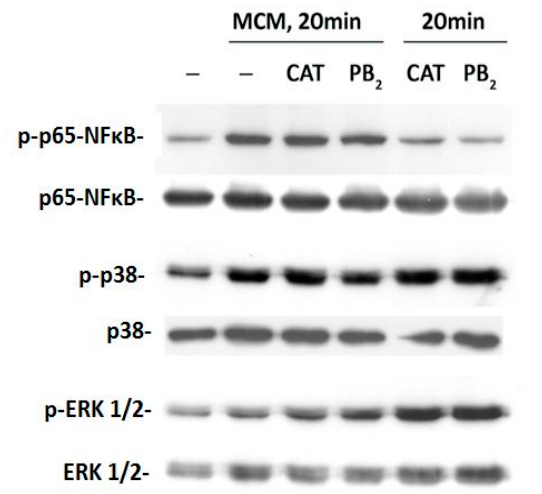
Figure 4. Transduction pathways activated by MCM in Caco-2/HT29-MTX co-cultures. Cell monolayers were incubated for 24 h in plain growth medium or with CAT or PB2 (50 µM). The